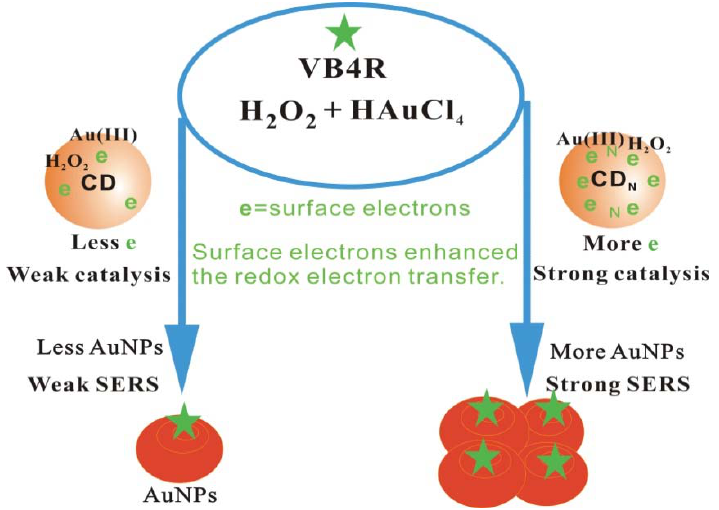
Figure 5. Enhancement of the doped N element.